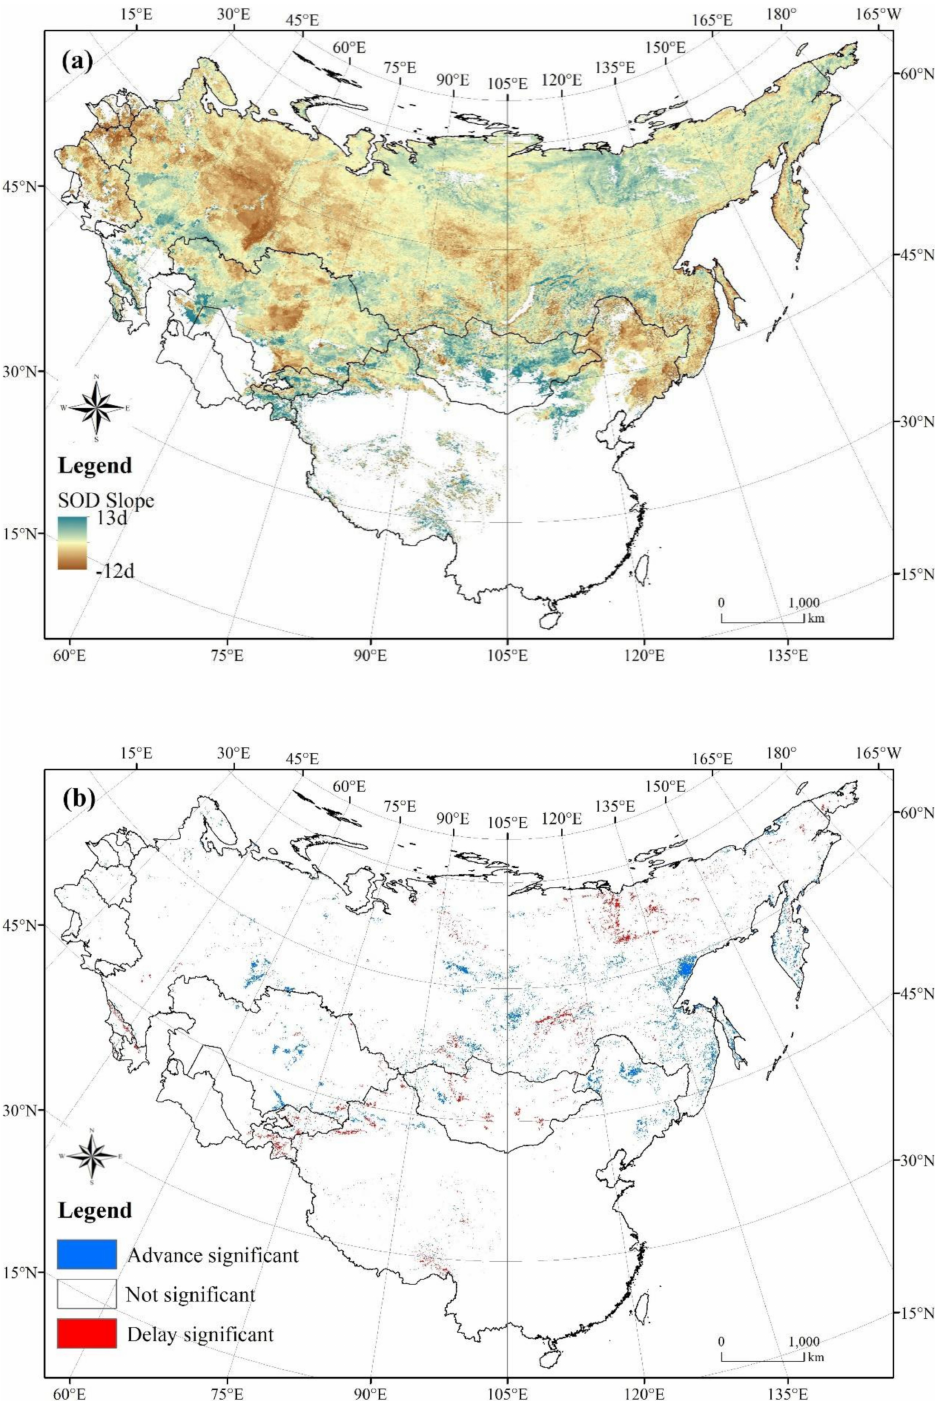
Figure 11. ( a ) The trend of SOD, and ( b ) the significant test in the study area from 2000 to